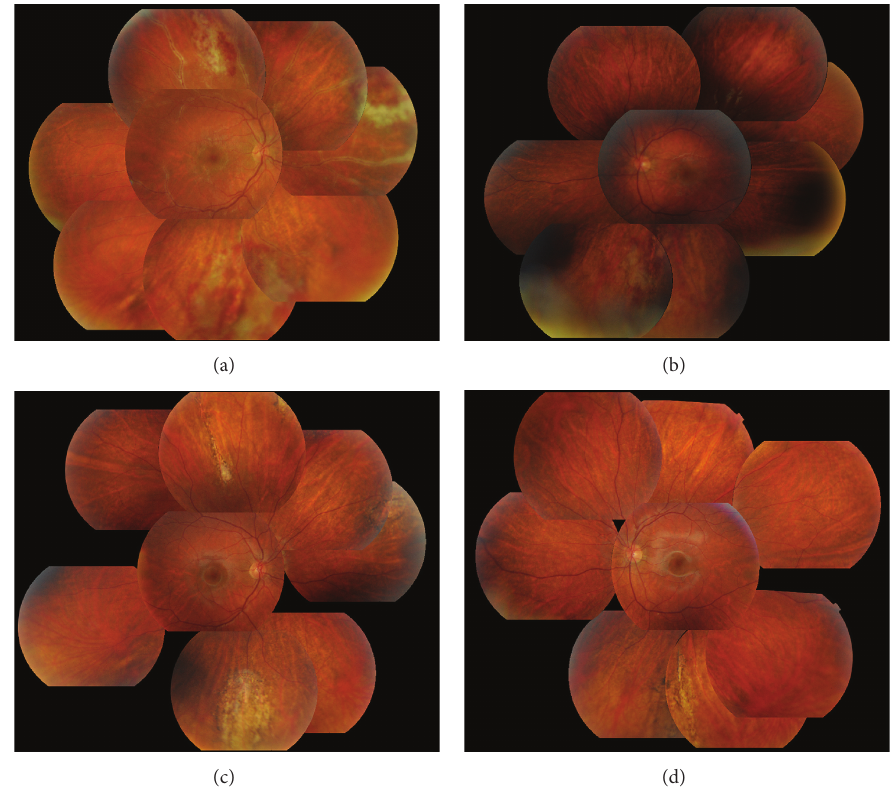
Figure 1: Color photographs of the right and left fundi. (a) Right eye fundus photograph at presentation showing active cytomegalovirus retinitis lesions (b). Left eye fundus photograph at the third day of treatment; the same retinal findings were also seen in the left eye but in a more limited pattern (c). And (d) two months after treatment, right and left fundus photographs show total resolution of active lesions, with the formation of chorioretinal scars, remission of